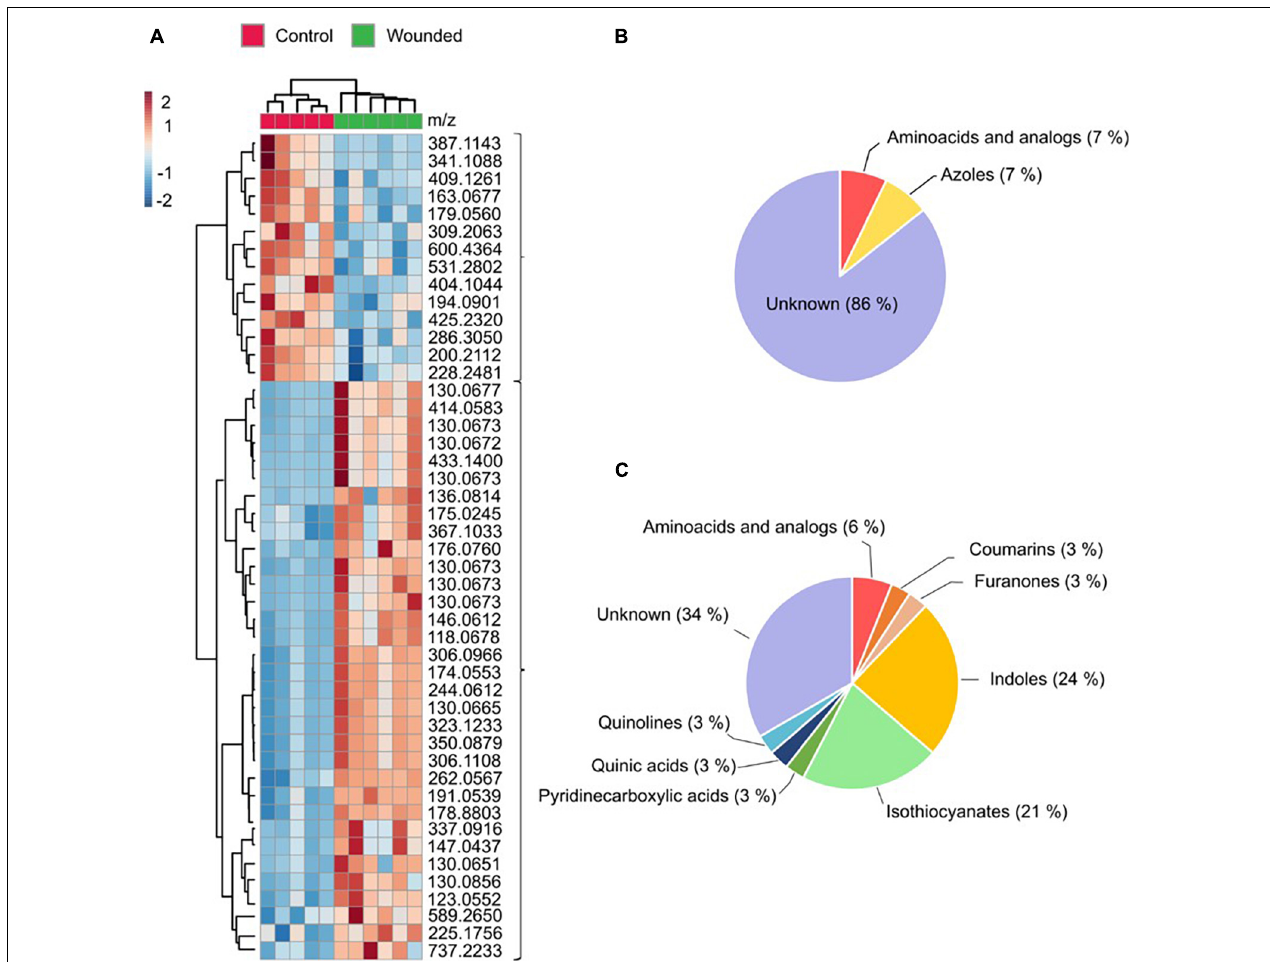
FIGURE 4 | Identification of metabolites involved in the wounding defensive response in broccoli ( B. oleracea var. botrytis ). Samples were harvested at dawn (ZT0). (A) Cluster heatmap analysis of the intensity of 47 metabolites differentially accumulated in response to wounding. (B) Grouping of cluster of metabolites with lower accumulation in wounded plants based on the ClassyFire chemical taxonomy. (C) Grouping of cluster of metabolites with higher accumulation in wounded plants based on the ClassyFire chemical taxonomy. The scale indicates the color code relative to the normalized metabolite abundance (ranging from –2 up to 2).